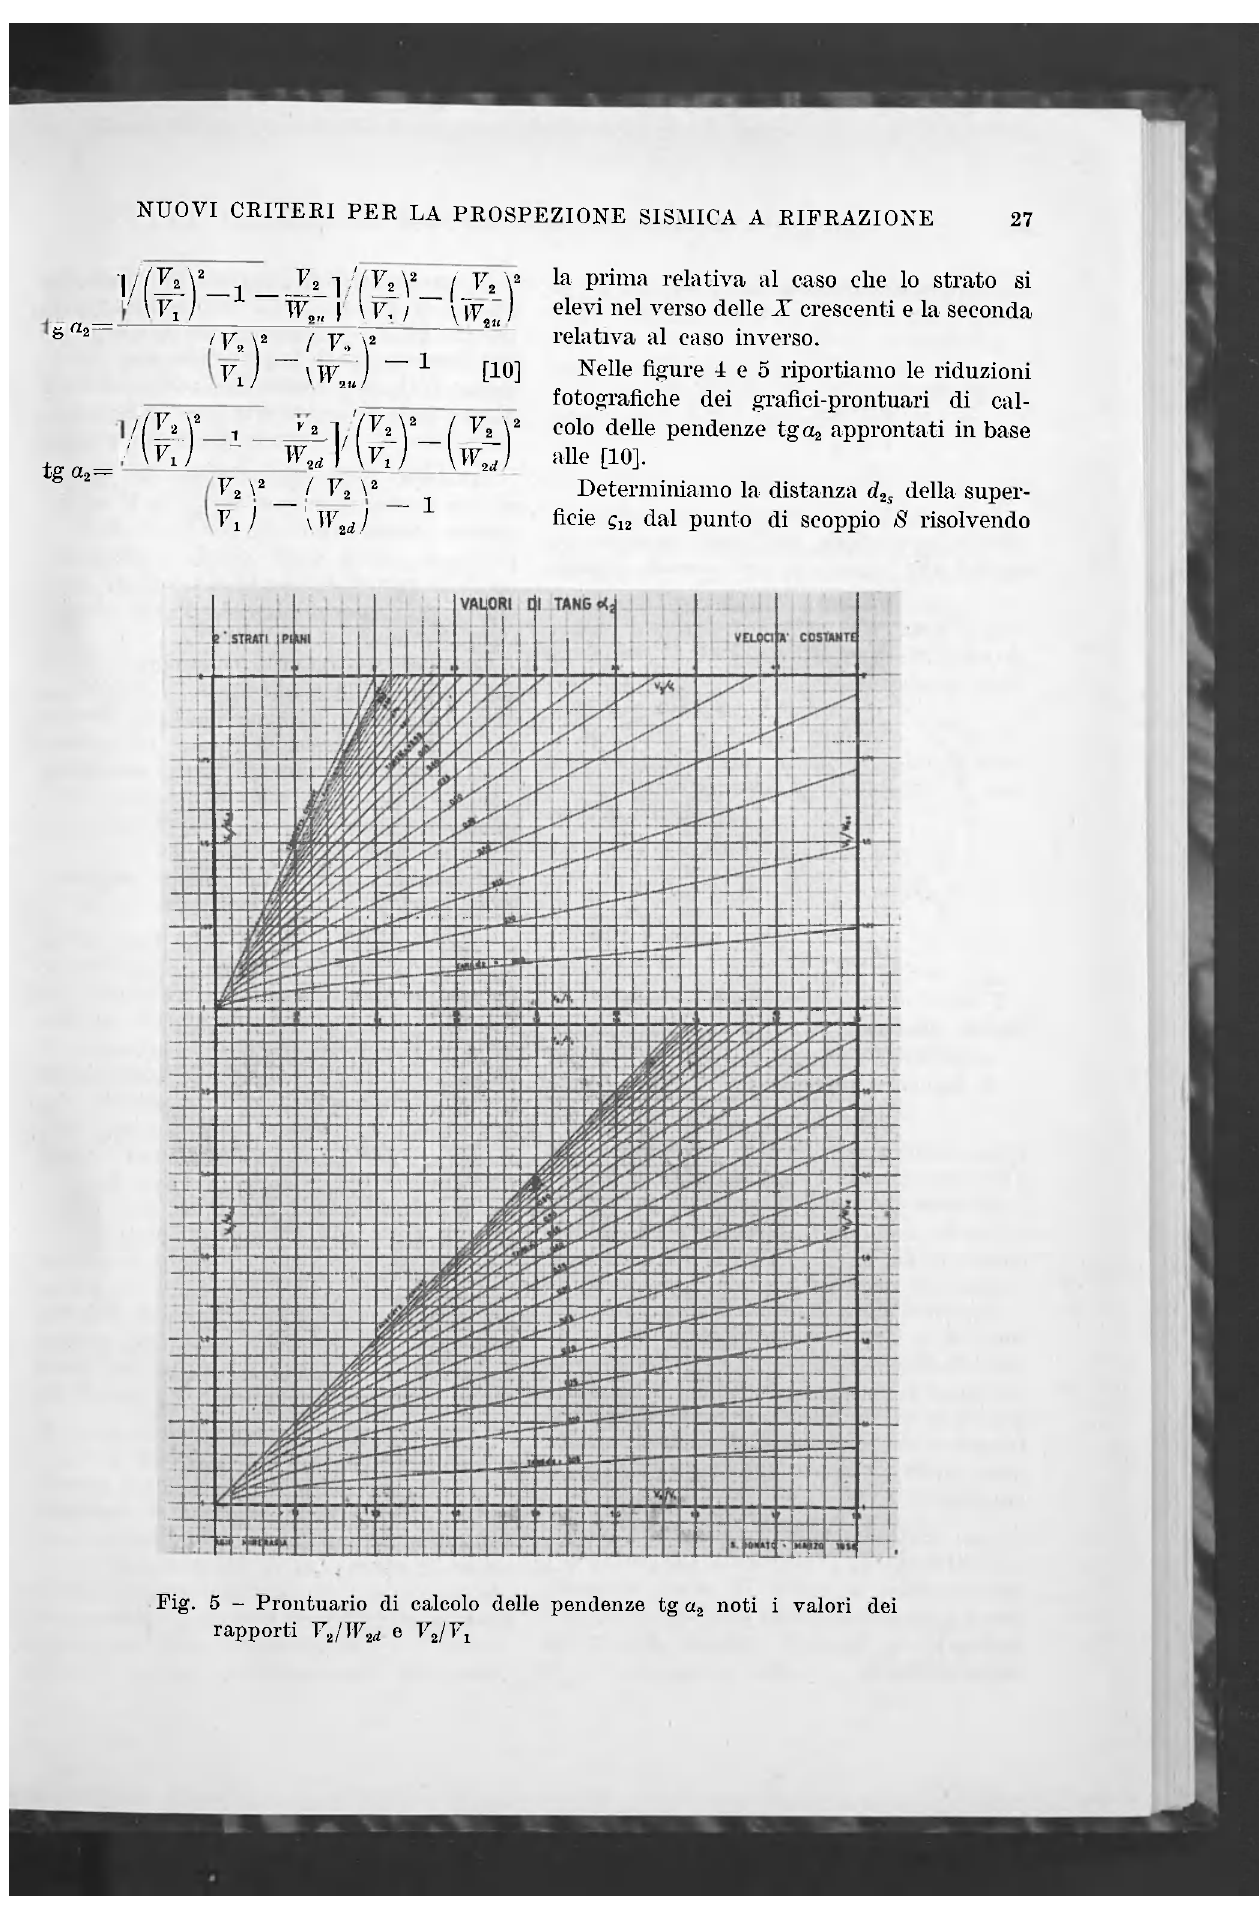
Fig. 5 - Prontuario di calcolo delle pendenze tg a 2 noti i valori